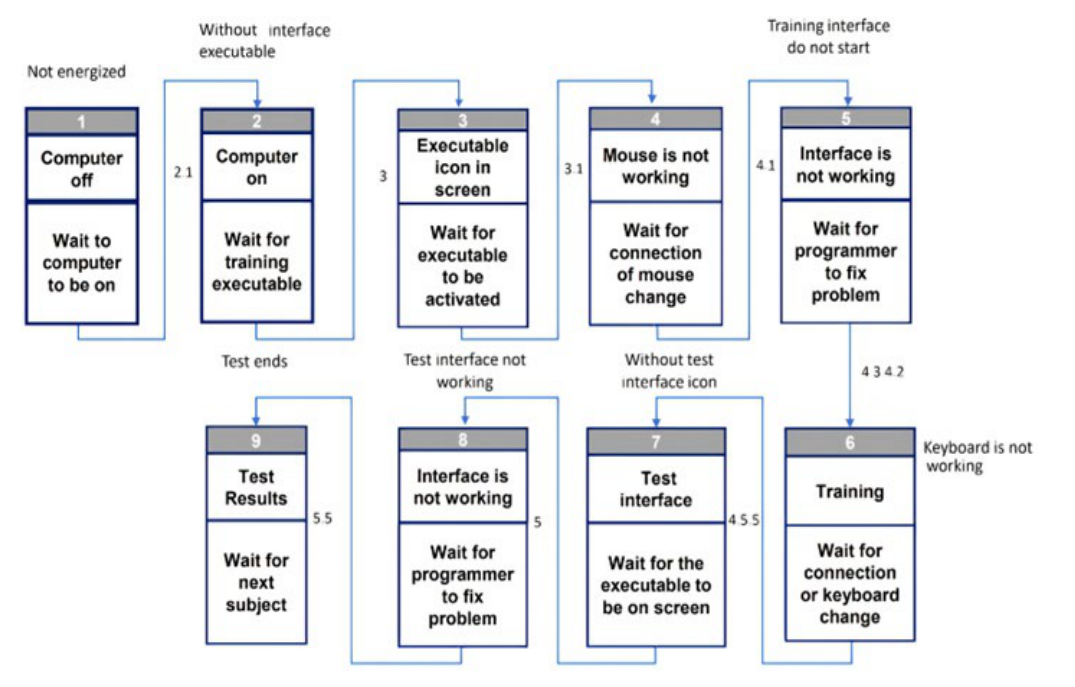
Figure 5. TAFEI method for human error analysis.